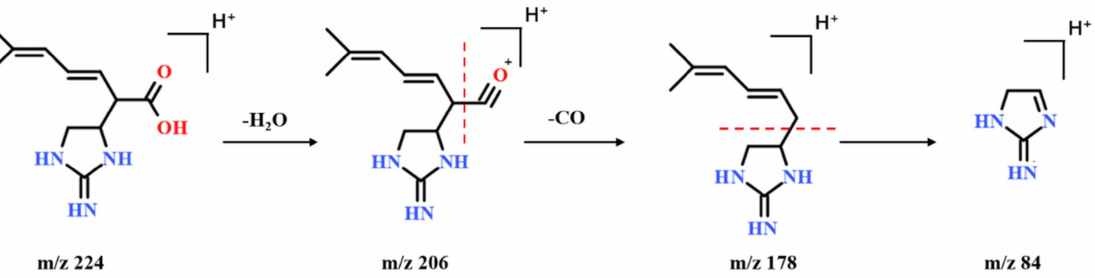
Figure 5. The possible fragmentation pathways of plumbagine B (compound 17 ) in the positive ion